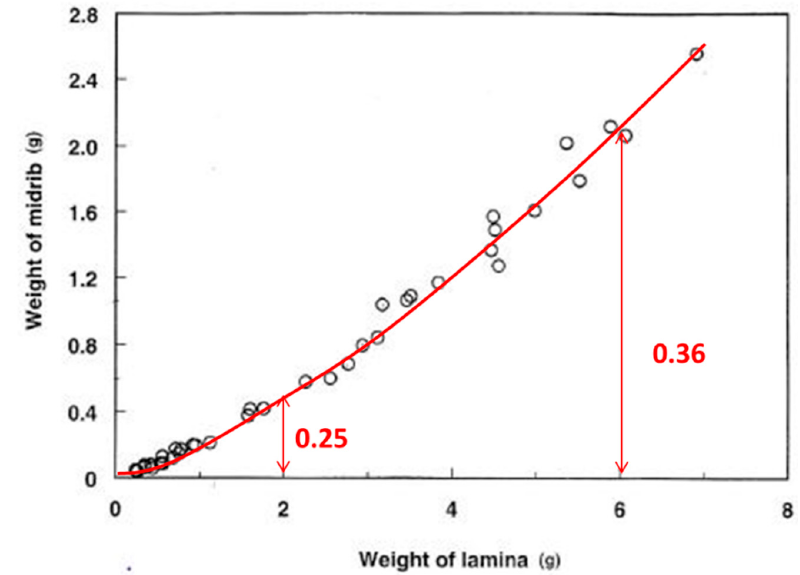
Figure 8. Relationship between the weight of midrib and the weight of lamina for successive leaves in a sweet sorghum plant. Redrawn from Fig 1.7 in Lemaire and Gastal [20]. Values in red are the midrib / lamina ratio that shows the increasing proportion of structural tissues as lamina size increases.